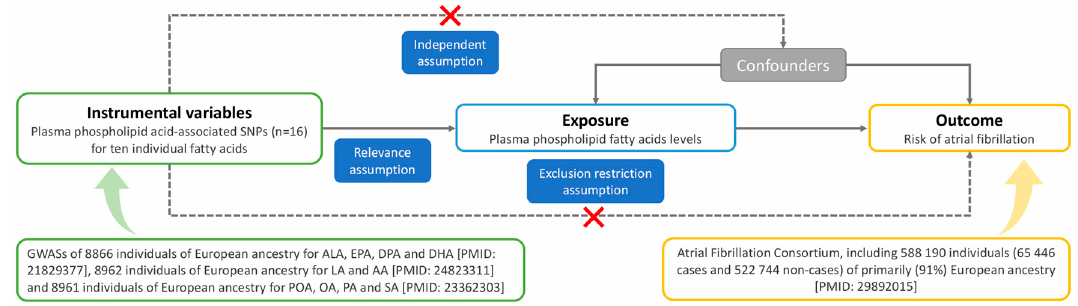
Figure 1. Schematic diagram of the Mendelian randomization assumptions underpinning a Mendelian randomization analysis of the association between plasma fatty acid (FA) levels and atrial fibrillation (AF). AA, arachidonic acid; ALA, α -linolenic acid; DHA, docosahexaenoic acid; DPA, docosapentaenoic acid; EPA, eicosapentaenoic acid; GWASs, genome-wide associations studies; LA, linoleic acid; OA, oleic acid; PA, palmitic acid; POA, palmitoleic acid; SA, stearic acid; SNPs, single-nucleotide polymorphisms.